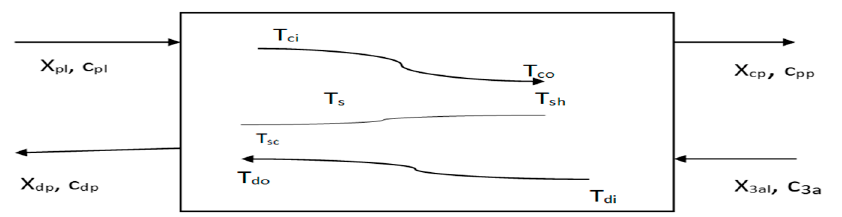
Figure 4. Profile of the charging and discharging process (Damirel and Ozturk [51]) . Table 1. Results of some of the studies presented on water heating and the PCM used.